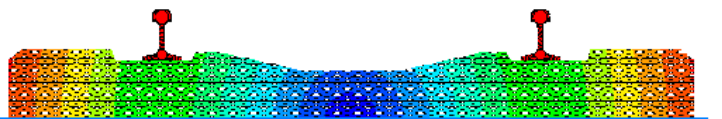
Figure 6. Steel-sleeper two-dimensional discrete element initial model diagram.